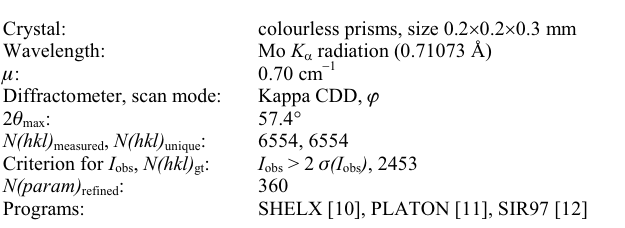
Table 1. Data collection and handling.